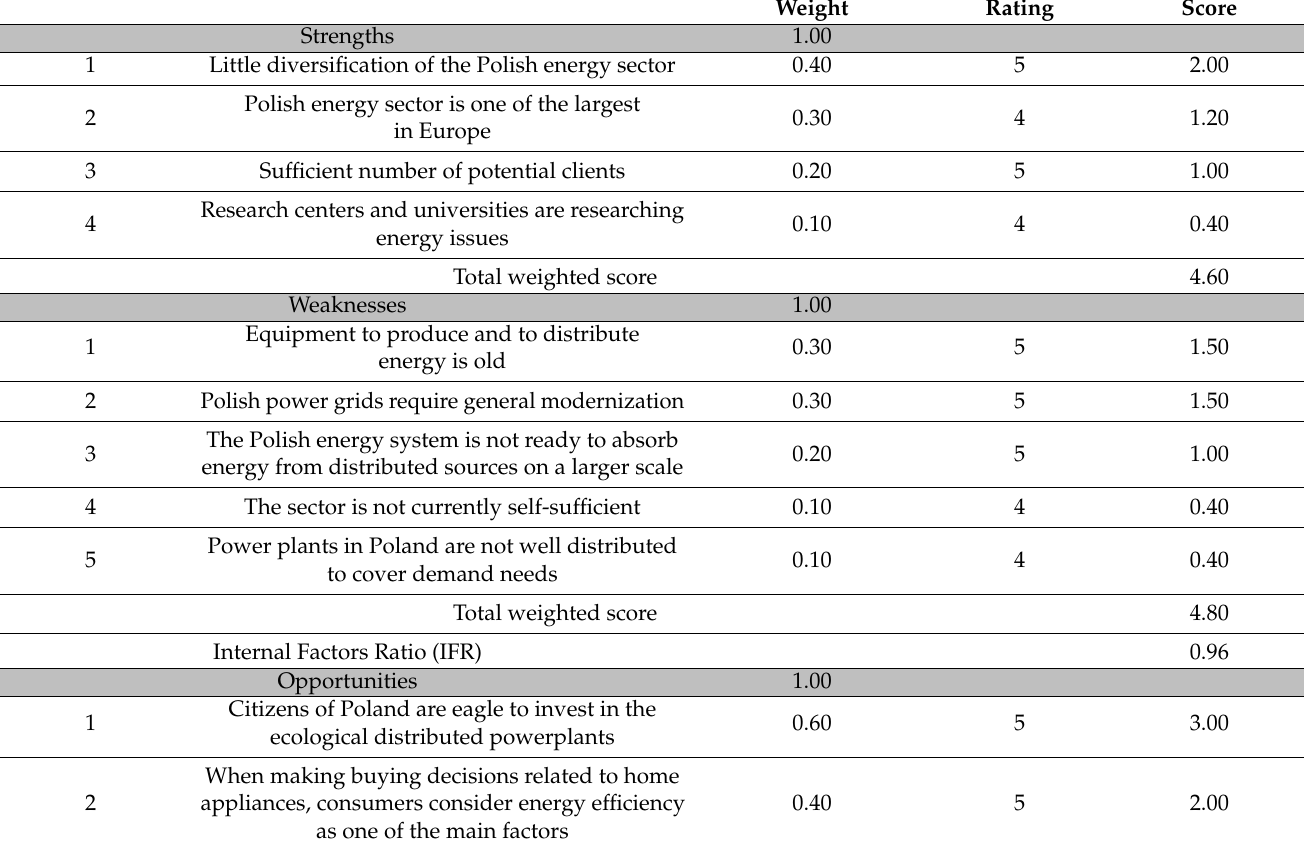
Table 3. Weighted SWOT matrix for the Polish energy sector.